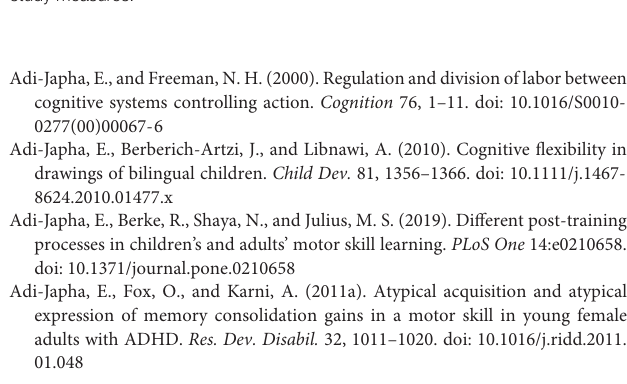
Supplementary Figure 1 | Wacom tablet placed on a slanted ergonomic board. Supplementary Figure 2 | An ILT block printed on a half A4 piece of paper placed on the slanted tablet. Supplementary Figure 3 | The ILTs’ computer program screen collecting data at action. Supplementary Table 1 | Means and standard deviations of main study